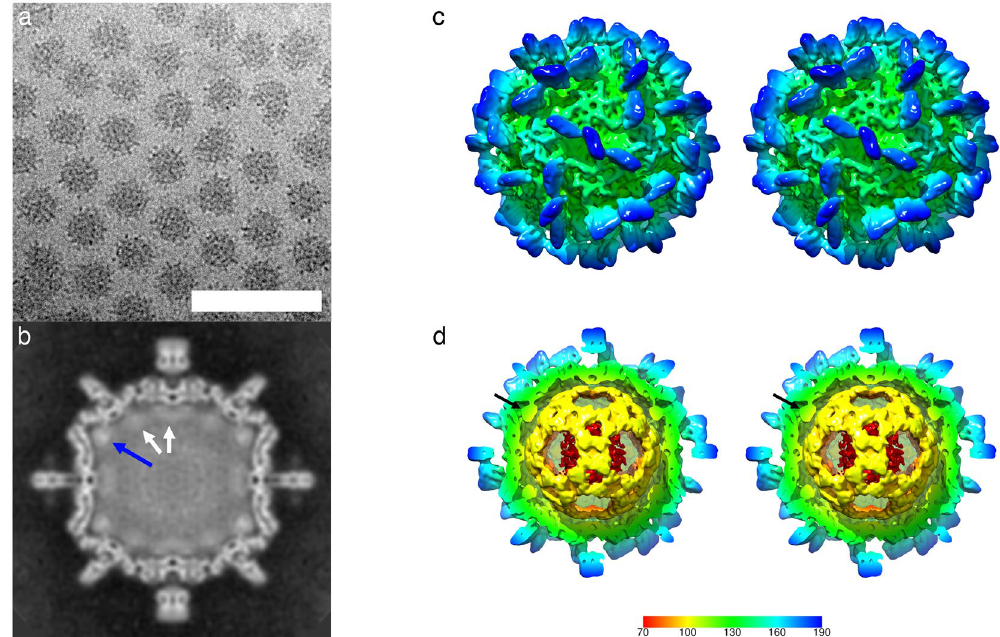
Figure 1. Cryo-Electron microscopy of Mr NV virus-like particles reveals a population of spikey icosahedral particles that package nucleic acids. ( a ) Cryo-EM of Mr NV VLPs revealed a population of isometric particles with pronounced spikes on the outer surface. VLPs were dense in projection, indicating that they packaged nucleic acids (Scale bar 100 nm). ( b ) A central section through the reconstructed Mr NV VLP density map shows a clearly defined capsid structure with pronounced spikes on the outer surface. Lining the capsid interior is a region of fuzzy density (white arrows) that we attribute to packaged RNA. The strongest density is seen to lay under the icosahedral five-fold symmetry axes and may represent RNA or a poorly-ordered N-terminal region of the capsid protein (blue arrow). ( c ) A wall-eyed stereo-pair image of the isosurfaced 3D reconstruction highlights the overall particle morphology featuring pronounced dimeric spikes on the capsid surface at the two-fold symmetry axes and arranged about the five-fold axes. ( d ) A cut-away view reveals that the internal density highlighted in ( b ) forms a dodecahedral cage, a feature previously documented in other nodavirus structures. The density underlying the five-fold symmetry axes is not, however, contiguous with this structure (black arrow). The colour key indicates the scale (in angstroms) of the radial colour scheme used in Figs 1(c,d), 2 and